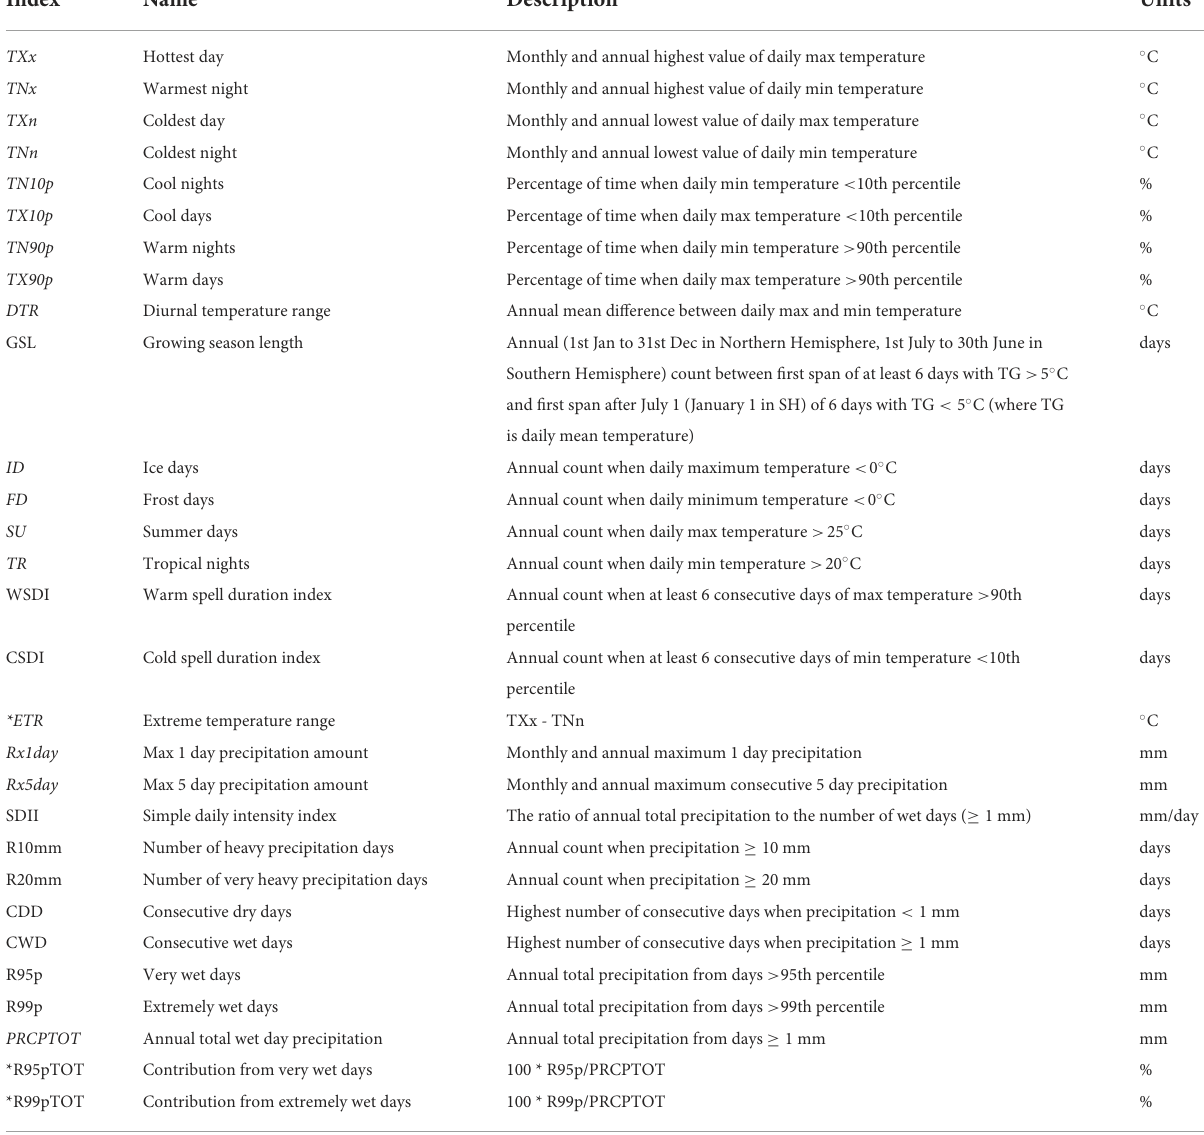
TABLE 1 Details of the ETCCDI indices used in this